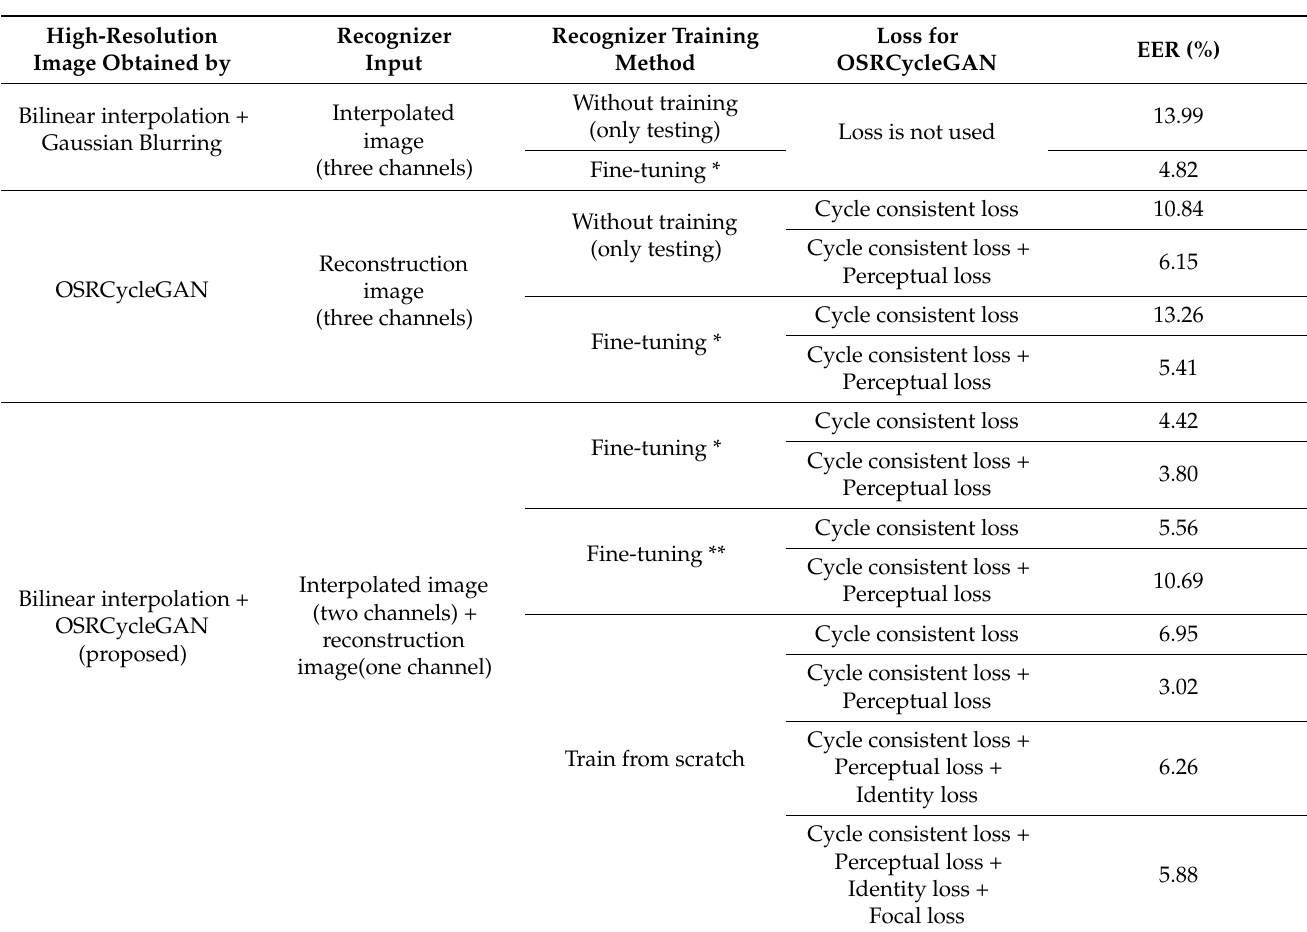
Table 7. Ocular recognition accuracy comparison in the case of using bilinear interpolation + Gaussian blurring when generating a low-resolution image (* means fine-tuning using the model pretrained with original high-resolution ocular images, and ** means fine-tuning using the model pretrained with